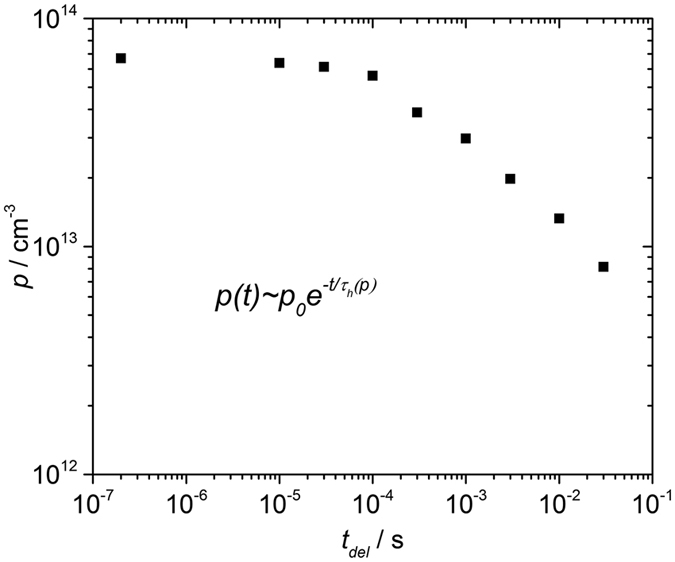
Photogenerated carrier density is plotted as a function of delay time tdel.